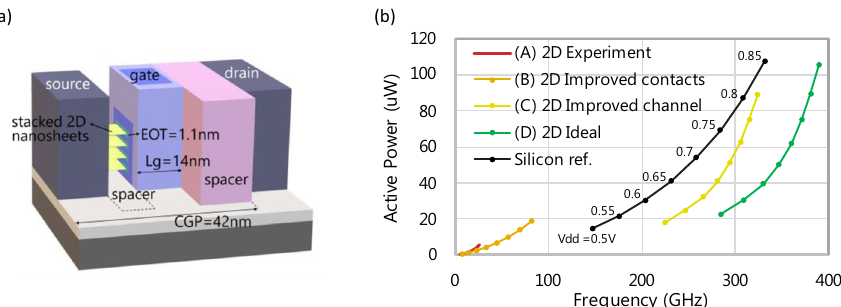
Figure 6. ( a ) Power performance area (PPA) analysis comparing silicon and 2D in the same configuration of 4 stacked nanosheets with gate-all-around. ( b ) The baseline (A) is set with experimental values, R c = 1.5 kΩ.µm (corresponding to Φ SB = 0.45 eV), µ = 15 cm 2 /Vs, D it = 3 × 10 12 cm −2 eV −1 , t channel = 3 layers. For (B) the contacts are improved with R c ≤ 50 Ω.µm (corresponding to Φ SB = 0.2 eV). For (C) the channel is further improved with µ = 200 cm 2 /Vs, D it = 1 × 10 12 cm −2 eV −1 , t channel = 1 layer. For (D), more aggressive improvements are done with µ = 450 cm 2 /Vs and no R c . For all curves, the area is the same and the bias conditions are such that at V dd = 0.7 V, I off is fixed at 2nA. Methodology from 44